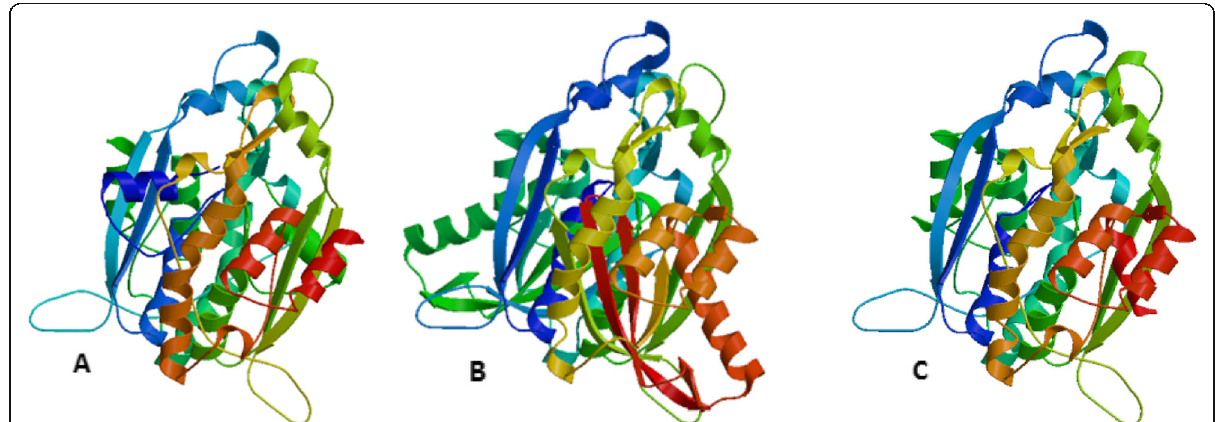
Fig. 4 Model 3D structure of protein from Curcuma longa a CURS1, b CURS2, and c